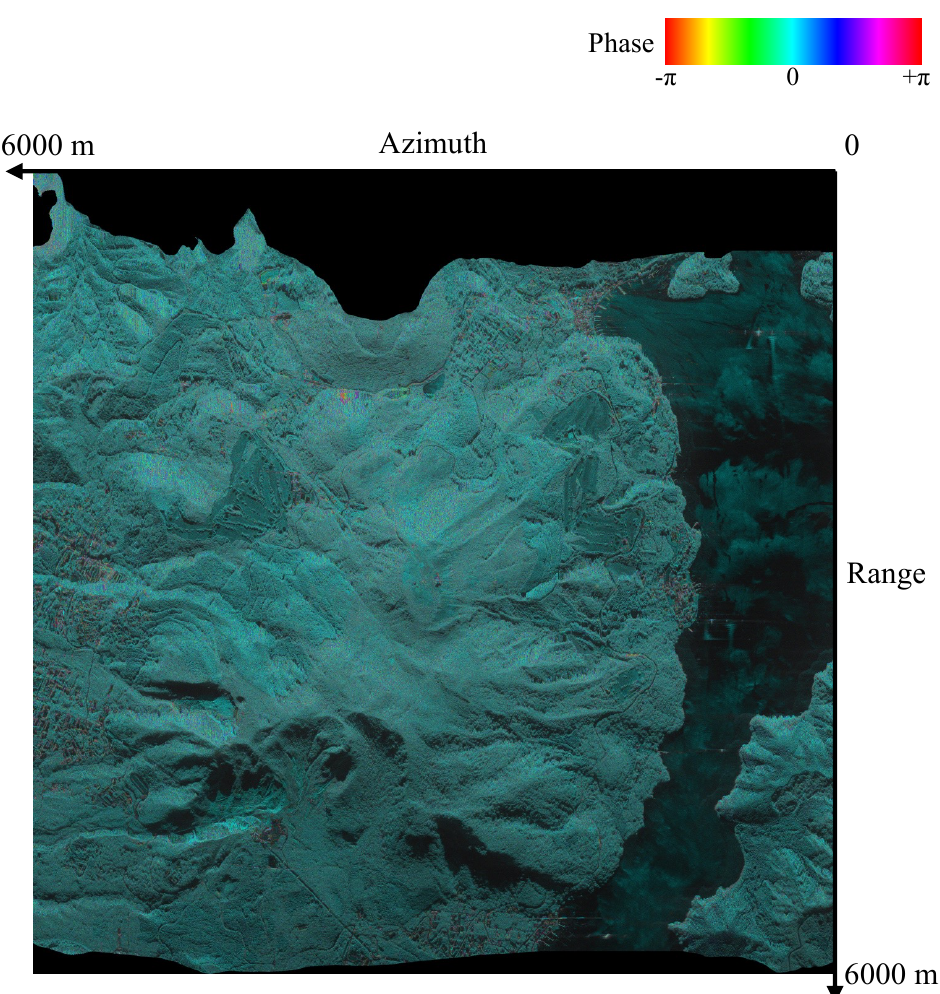
Figure 19. VVm image after orthorectification around Mount Hakone on 3 December 2015 (Center: N35.218,